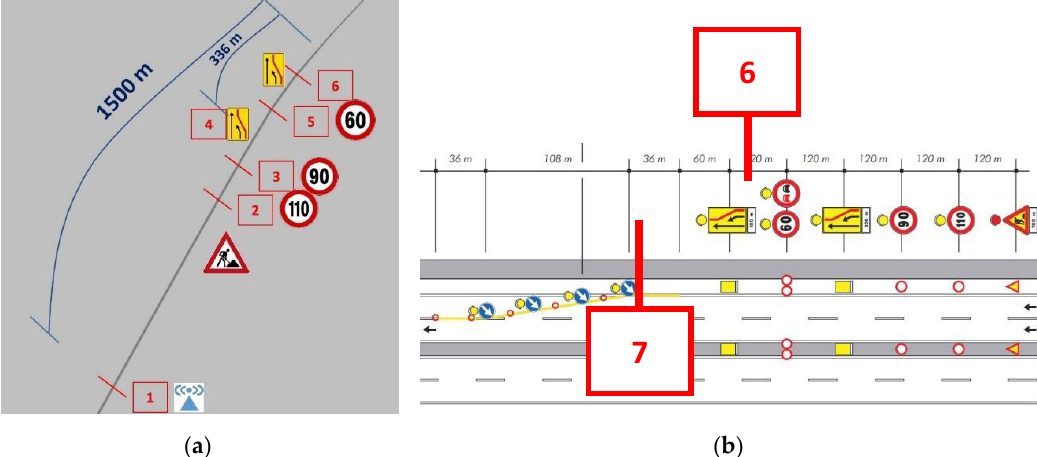
Figure 2. ( a ) Network as reproduced within the model, and ( b ) roadworks layout as prescribed by the Italian law [3]. Adapted from [3] .